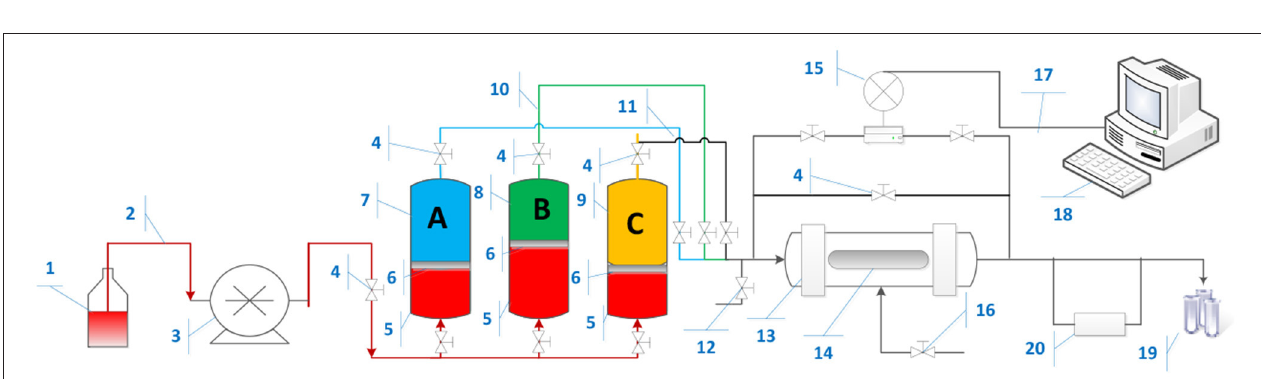
FIGURE 4 | Nanoparticles coreflooding apparatus. (1) Pump fluid (Exxol D60); (2) injection line; (3) Quzix Pump; (4) Valve; (5) Pump Fluid in reservoir; (6) Piston plate; (7) Brine; (8) Nanofluids; (9) Nanofluids; (10) Oil line; (11) Brine/Nanofluids line; (12) Bypass Valve; (13) Hassler Core Cell; (14) Core plug; (15) Pressure gauge; (16) Sleeve pressure; (17) connection cable; (18) Computer; (19) Accumulator; (20) electrical resistivity meter.